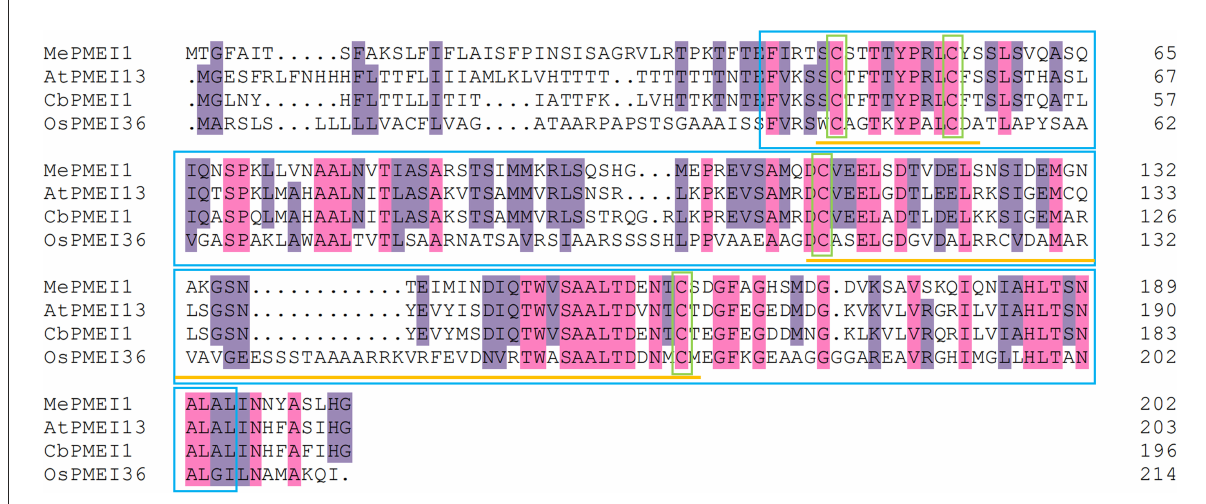
FIGURE1 Multiple sequence alignment and analysis of conserved domains of the MePMEI1 protein and other PMEIs from different plant species. The purple and pink highlights indicate similar and identical residues, respectively. The PMEI domain and conserved cysteine residues are outlined in blue and green boxes, respectively. The disulfide bridges are underlined in